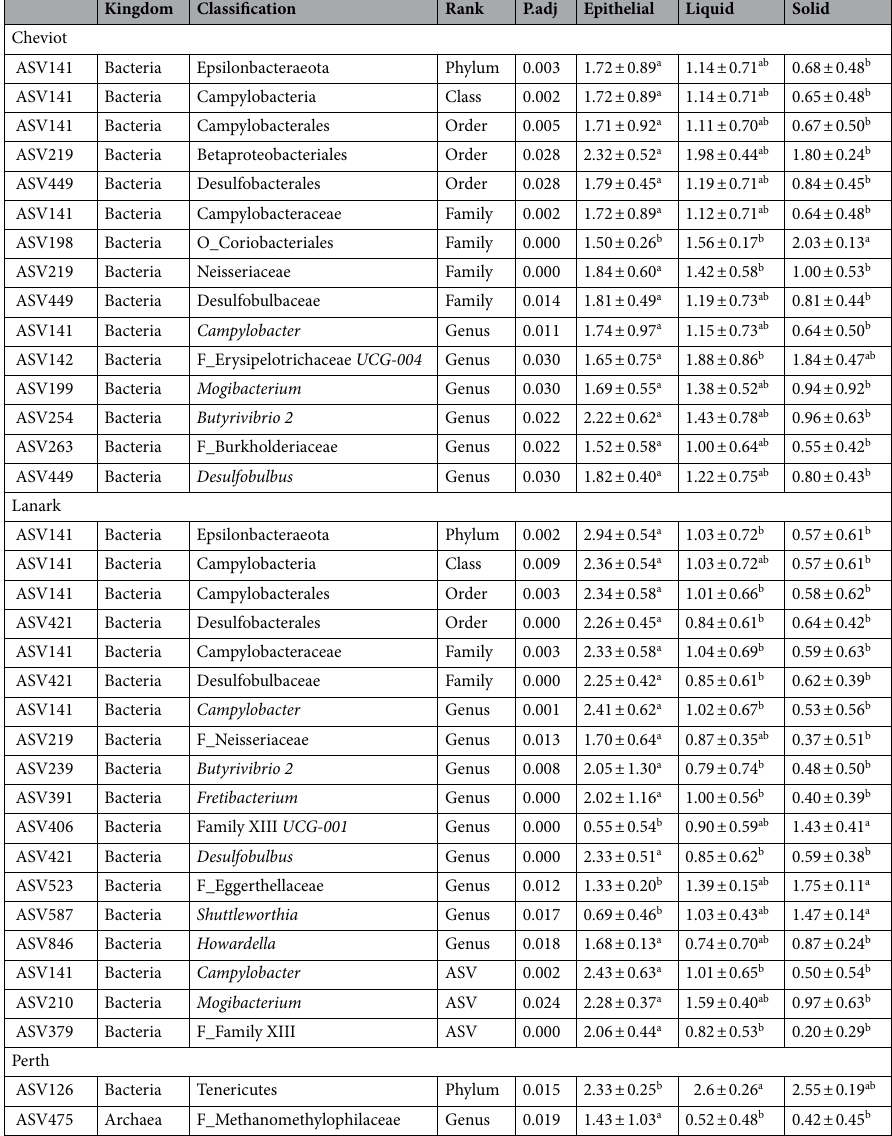
Table 8. Differential abundance analysis investigating the effect of ruminal fraction on the abundance bacterial and archaeal taxa in Cheviot, Lanark and Perth breeds. Analysis was conducted across all taxonomic ranks for bacterial populations (Phylum, Class, Order, Family, Genus and ASV), and lower taxonomic ranks for archaeal populations (Genus and ASV) using the LRT from DESeq2. Table reports significant findings along with the log10 of normalised counts (Mean ± Sd), BH adjusted P values, pairwise comparisons (superscripts). Taxonomic rank and classification. Cheviot (solid n = 7, liquid n = 7, epithelial n = 7), Lanark (solid n = 5, liquid n = 5, epithelial n = 5), Perth (solid n = 5, liquid n = 5, epithelial n =